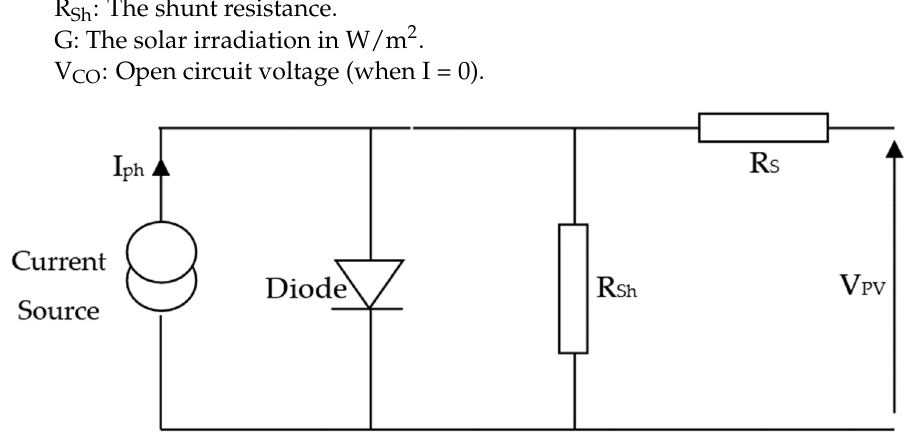
Figure 2. Equivalent circuit of PV panel.